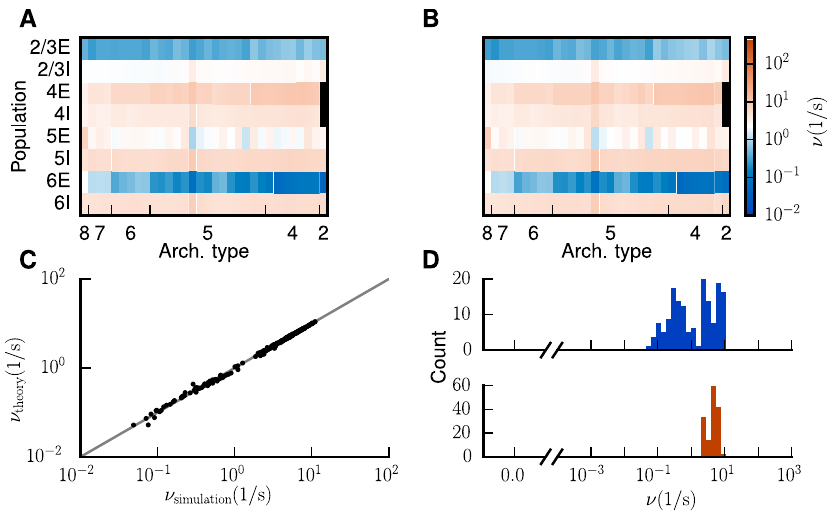
Fig 9. Improved low-activity fixed point of the model. Population-averagedfiring rates for k ¼ 1 : 125 encodedin color ( A ) predicted by the analyticaltheory and ( B ) obtainedfrom the full simulationof the spiking network. Same displayas in Fig 3. C Analytical versus simulatedfiring rates (black dots) and identity line (gray). D Histogram of population-averaged simulatedfiring rates. Same displayas in Fig 3.